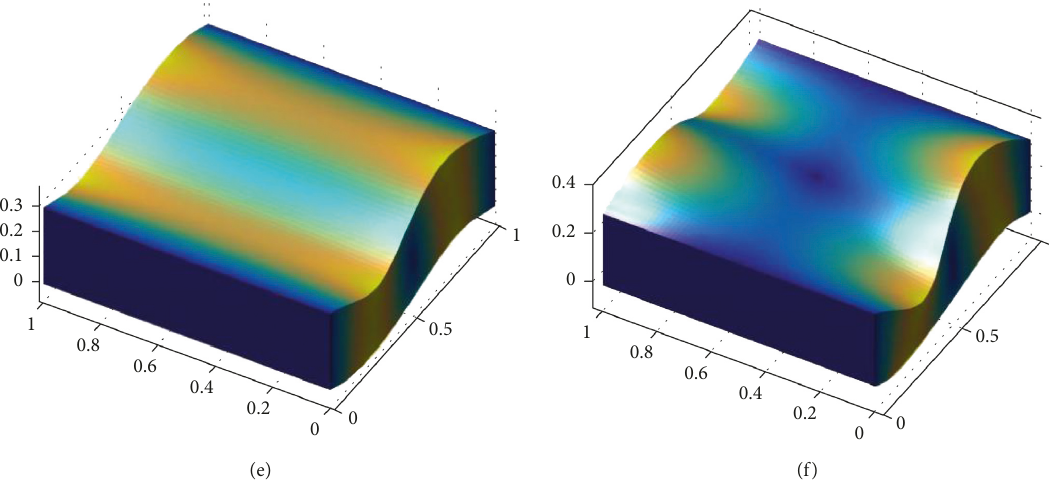
Figure 7: Mode shapes of orthotropic rectangular plates with the CFCF boundary condition: (a) 1st mode; (b) 2nd mode; (c) 3rd mode; (d) 4th mode; (e) 5th mode; (f) 6th